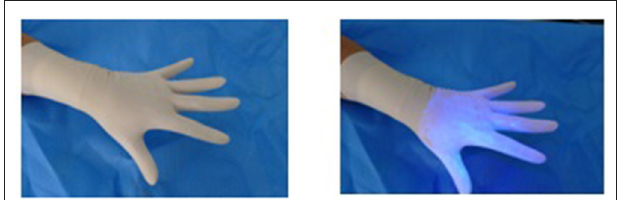
FIGURE 1 | Glitterbug TM coating the top glove.